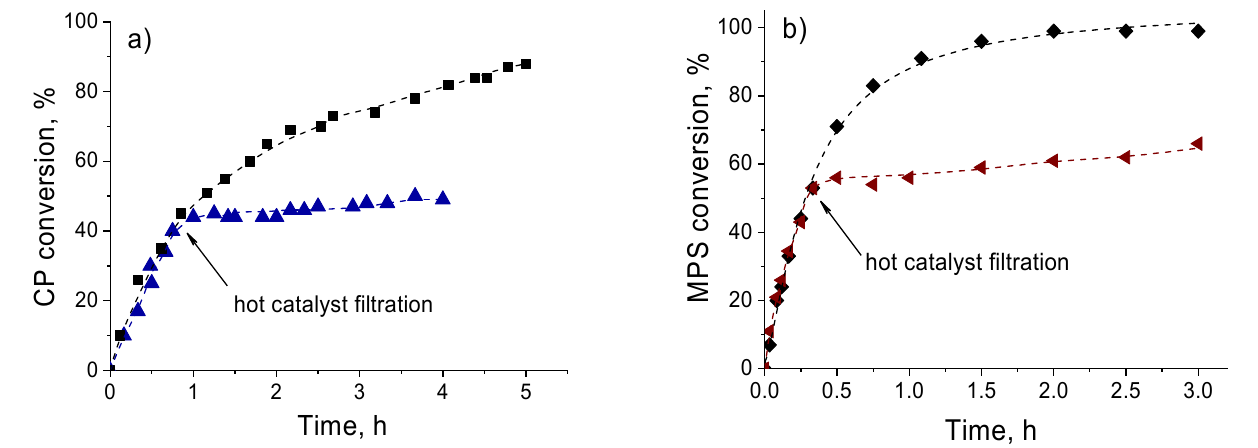
Figure 16. Hot catalyst filtration test for ( a ) CP and ( b ) MPS oxidation with H 2 O 2 in the presence of Zr-MMM-E (sample D ). Reaction conditions: MPS 0.1 mmol, catalyst 5 mg (0.0013 mmol Zr), H 2 O 2 (30% aq.) 0.22 mmol, CH 3 CN 1 mL, 60 °C.